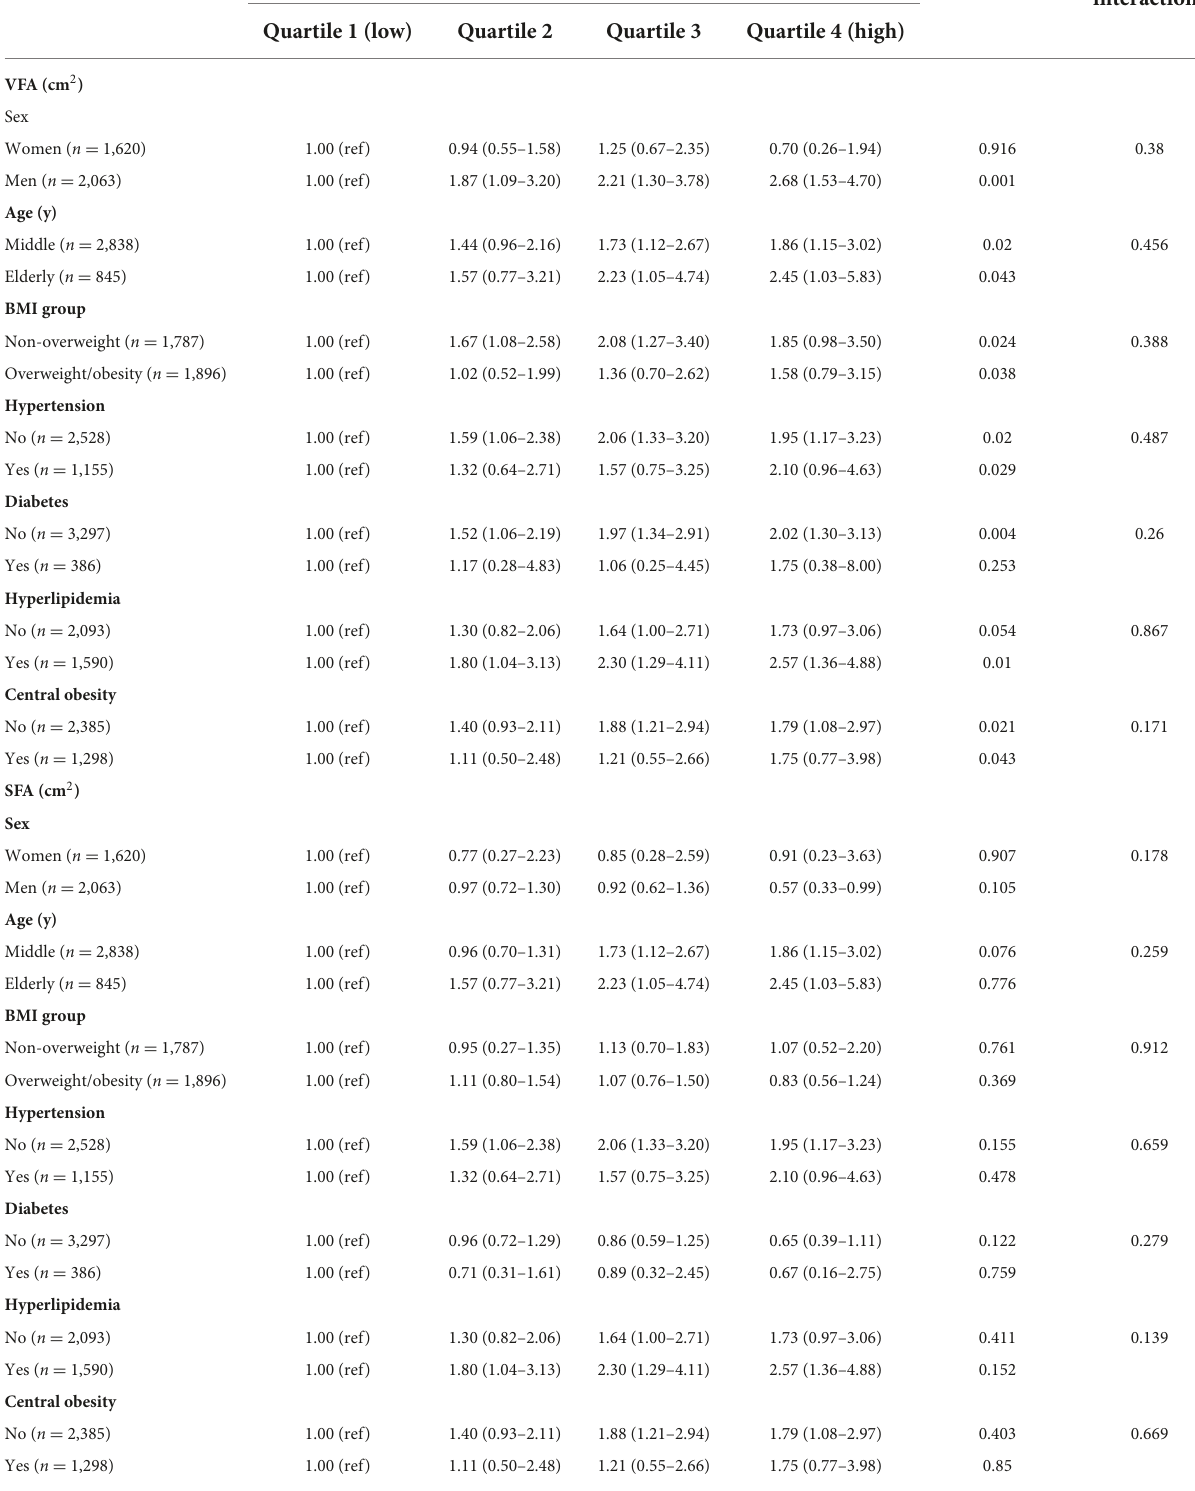
TABLE 3 Stratified associations between VFA, SFA, LFC, and hyperuricemia by sex, age, BMI, hypertension, diabetes, hyperlipidemia, and central obesity ( N = 3,683). Quartiles of adipose